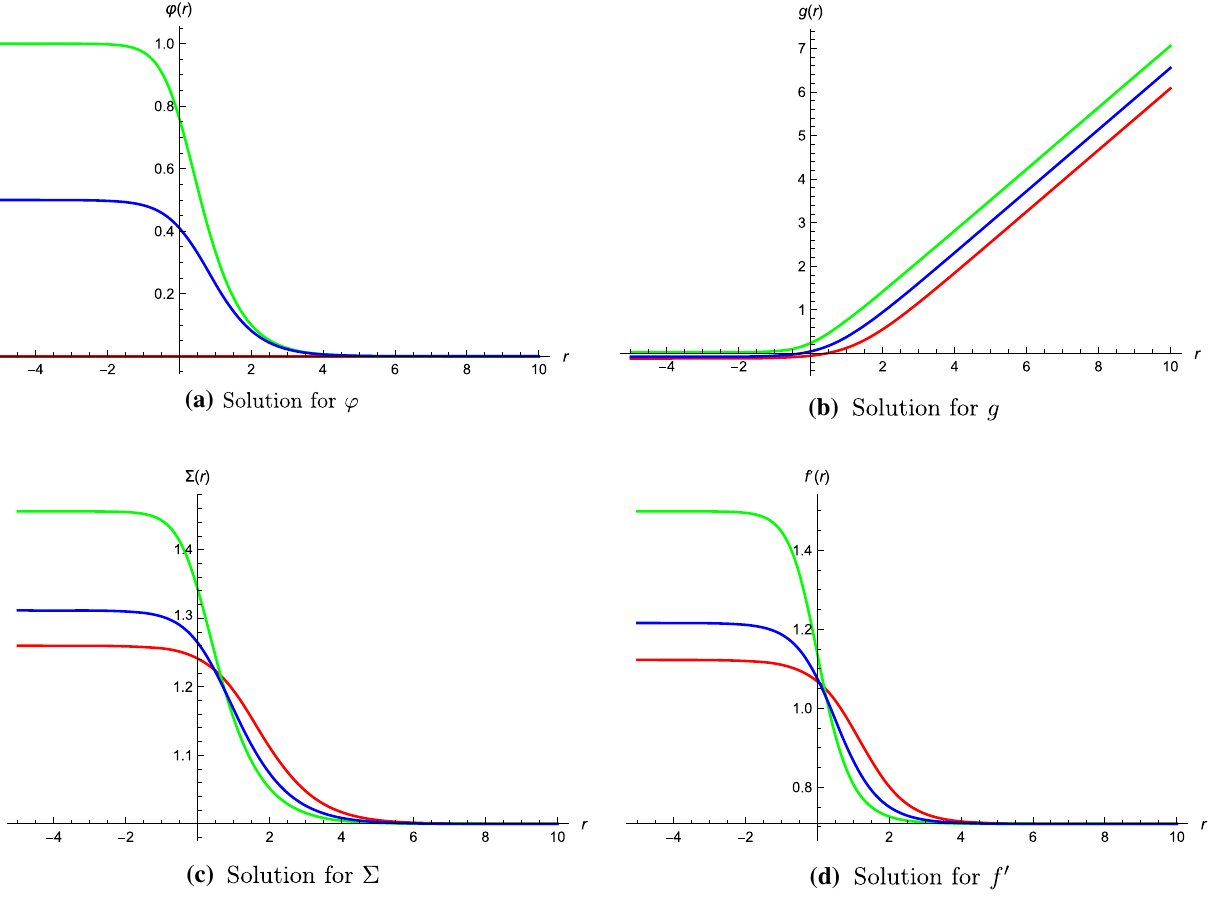
Fig. 1 RG flows from N = 4 AdS 5 critical point with U ( 1 ) × SU ( 2 ) × SU ( 2 ) symmetry to N = 4 AdS 3 × H 2 geometries in the IR with g 1 = 1 and ϕ 0 = 0 (red), ϕ 0 = 0 . 5 (blue) and ϕ 0 = 1